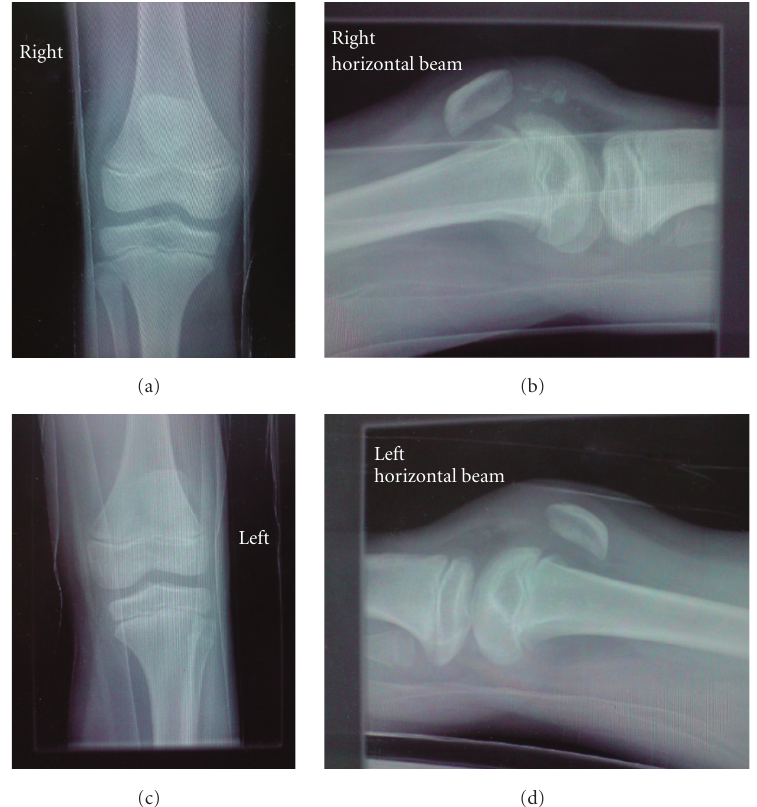
Figure 2: (a) AP radiograph of the right knee. (b) Lateral radiograph of the right knee. (c) AP radiograph of the left knee. (d) Lateral radiograph of the left